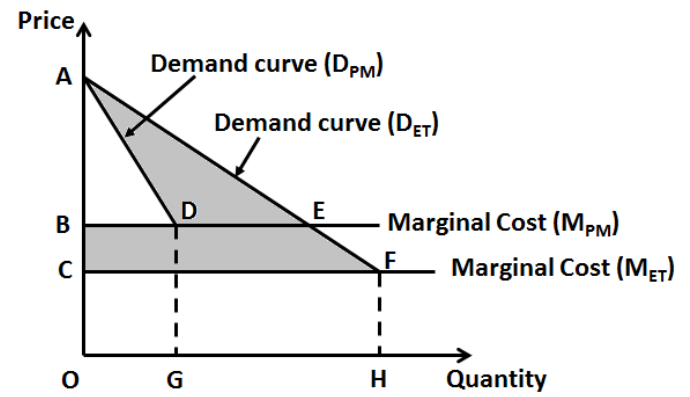
Figure 1. Impact of personalized medicine on total revenues of already existing pharmaceutical treatment entities. M PM refers to the marginal cost following adoption of precision therapy and M ET refers to the marginal cost of the current empirical therapy. ΔABD-total revenue of already existing entity from personalized medicine; A sum of ‘ADE’ and ‘BCFE’ would be the total loss (or lost revenues) from personalized medicine.